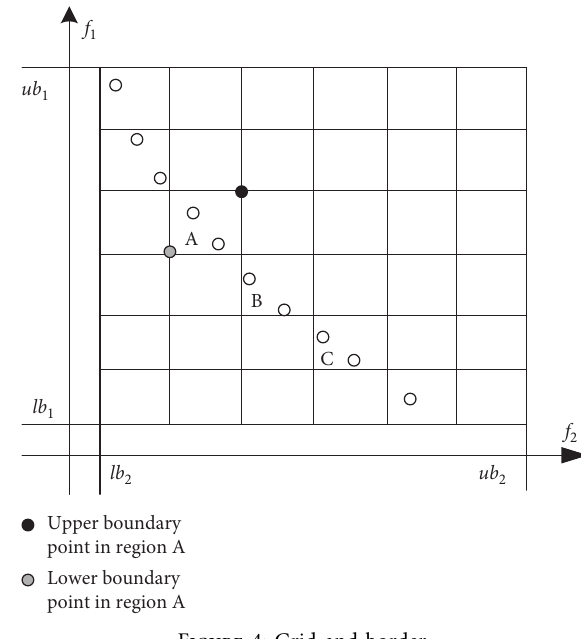
Figure 4: Grid and